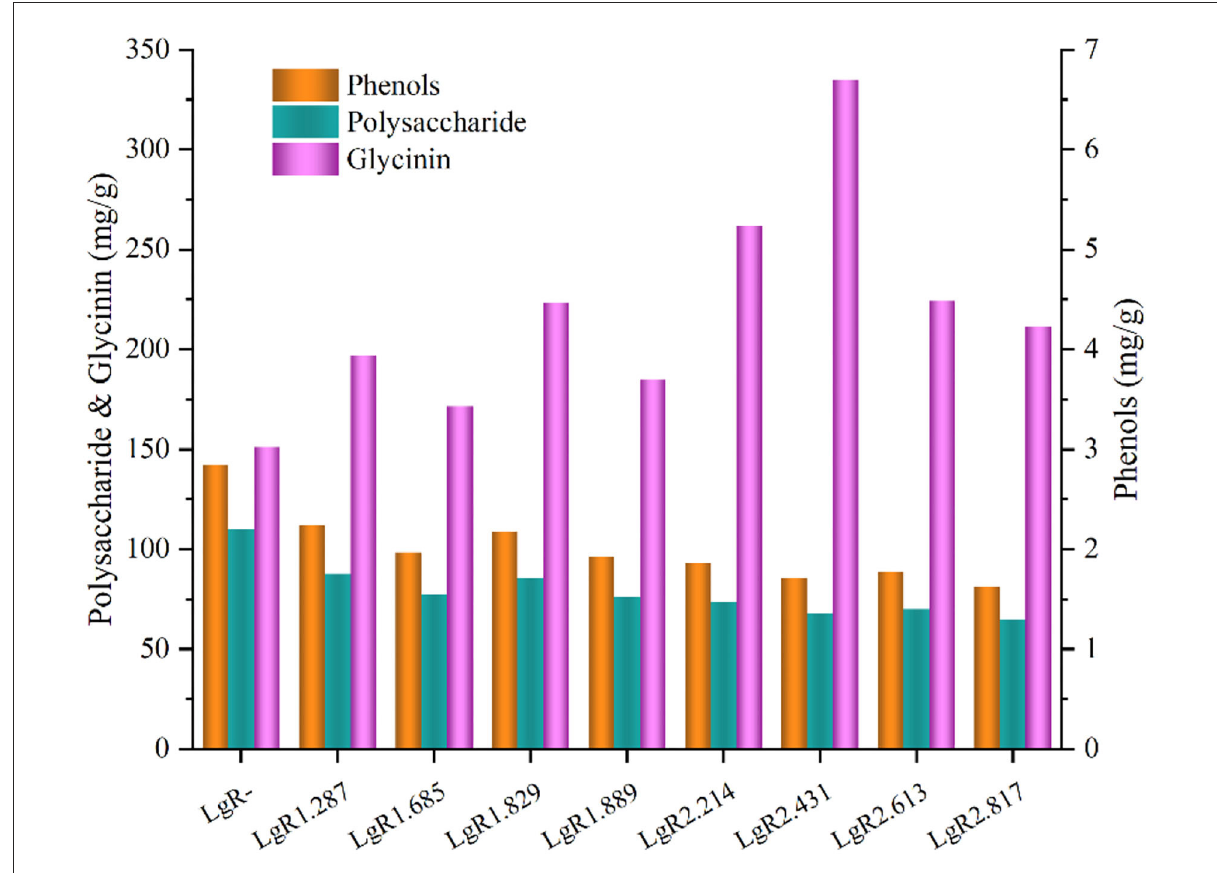
FIGURE4 Chemical compositions of soybean meal. LgR indicates the steam explosion severity.